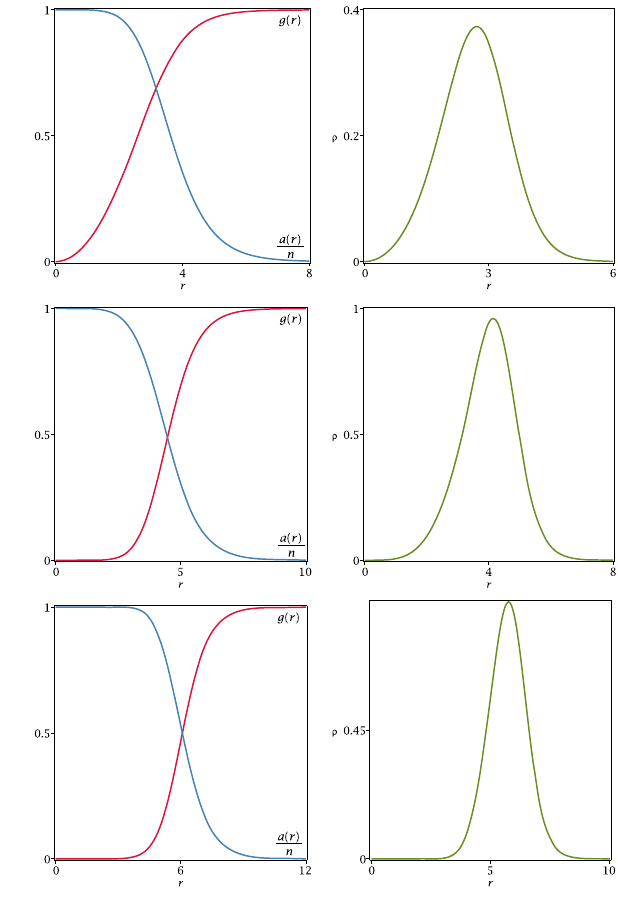
Fig. 6 Solutions of (18) with permeabilities given by (28). In the left, we depict the vortex solutions g 1 ( r ), g 2 ( r ), g 3 ( r ) (red lines, from top to bottom) and a 1 ( r )/ n 1 , a 2 ( r )/ n 2 , a 3 ( r )/ n 3 (blue lines, from top to bottom). In the right, we depict the corresponding energy densities ρ ( r ),ρ ( r ) , and ρ ( r ) (top to bottom). Here, n 1 2 3